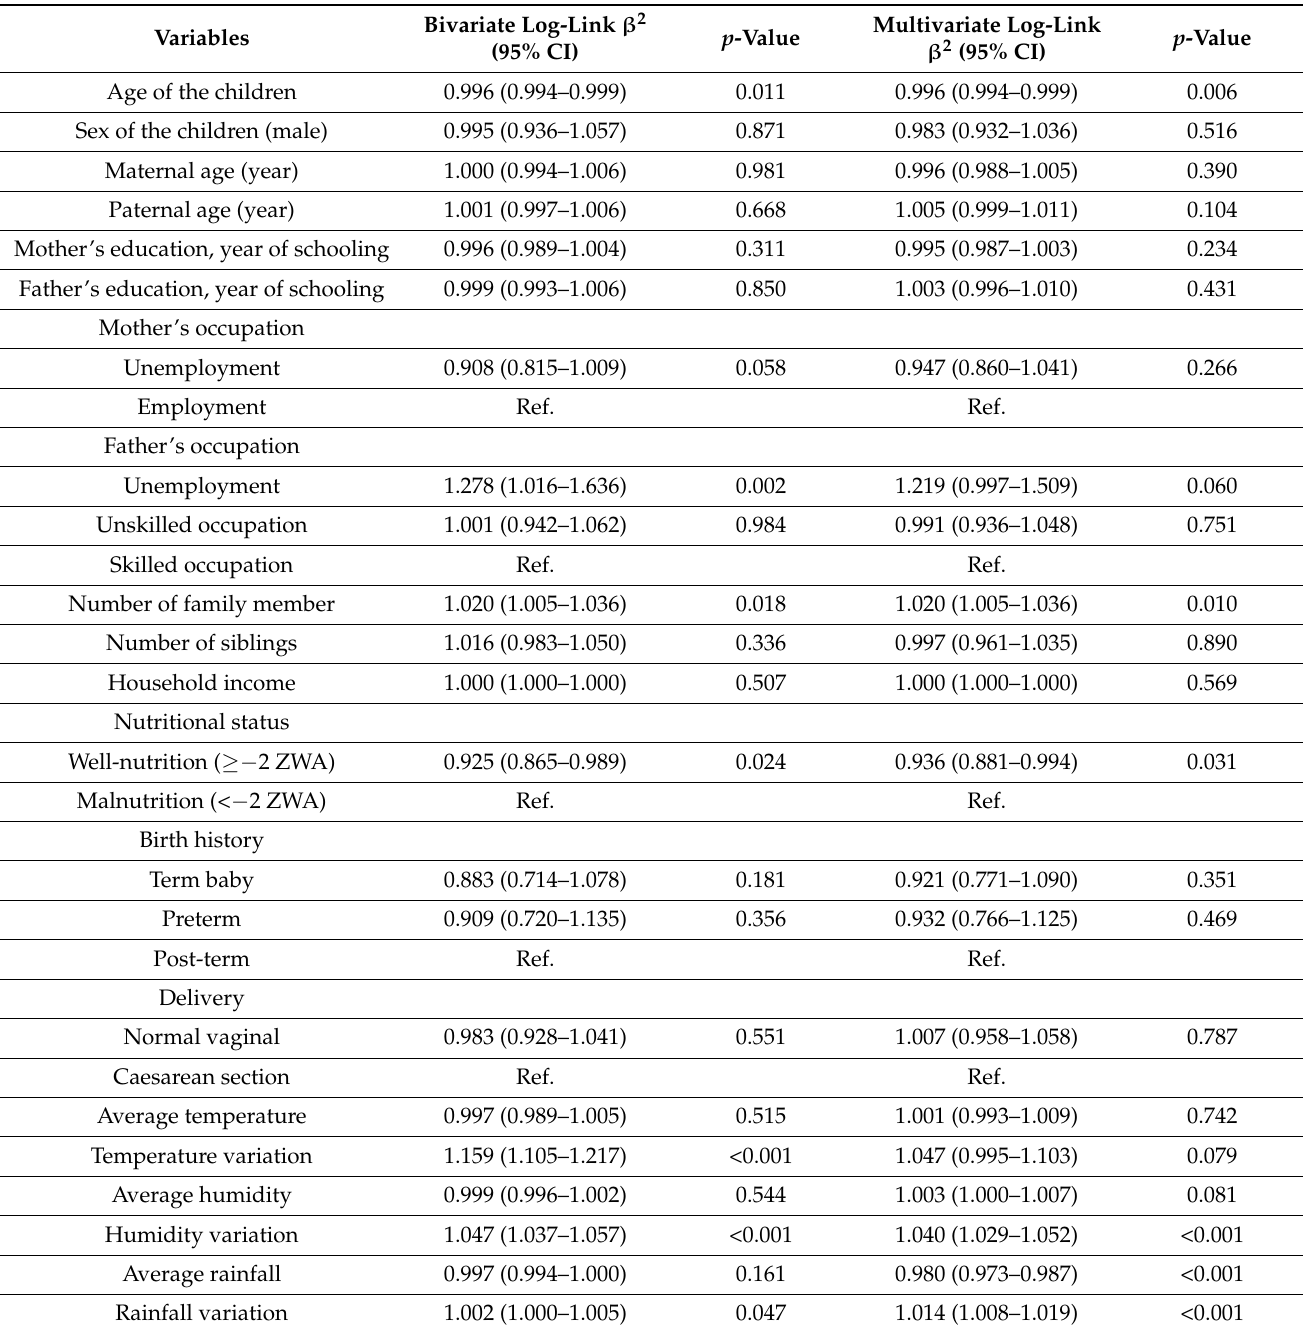
Table 3. Bivariate and multivariate coefficients ( β ) with 95% Cl of explanatory variables by generalized linear model with gamma